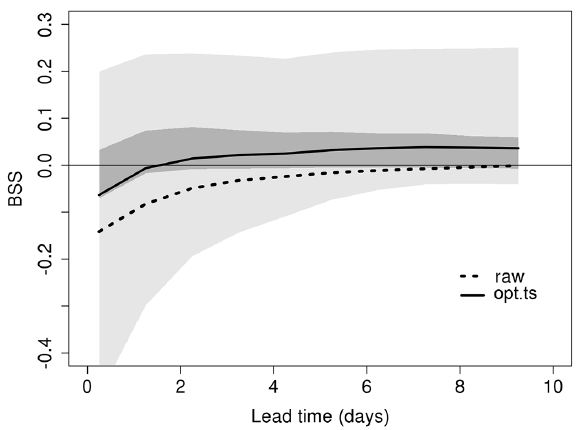
Figure 3. BSS of the ERI vs. lead time for the raw forecasts (aver- age BSS with a dashed line) and considering the optimal time shift (average BSS with a solid line; shadings indicate the 5–95% range, in light grey, and the 25–75% range, in dark